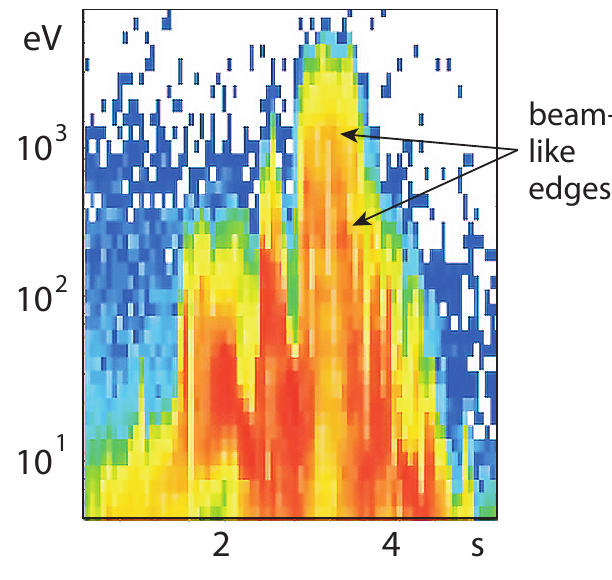
Fig. 3. Expanded view of the second downward current event in Fig. 2, showing that the upward electron fluxes consists of several neighbouring events each one being sharp-edged in energy with in- tensified energy flux close to the highest energies at the particular times. These edge features add up to the average high-energy beam- like increase in the upward electron distribution function of Fig.